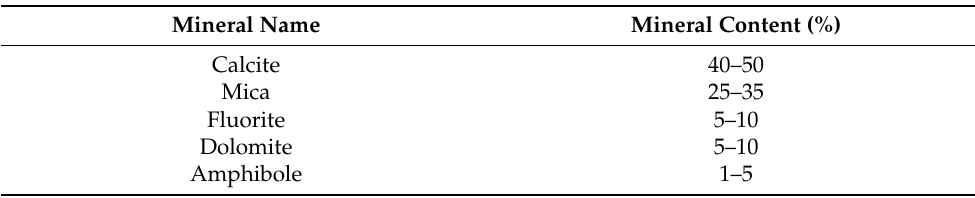
Table 4. Analysis results of mineral composition of tailings.